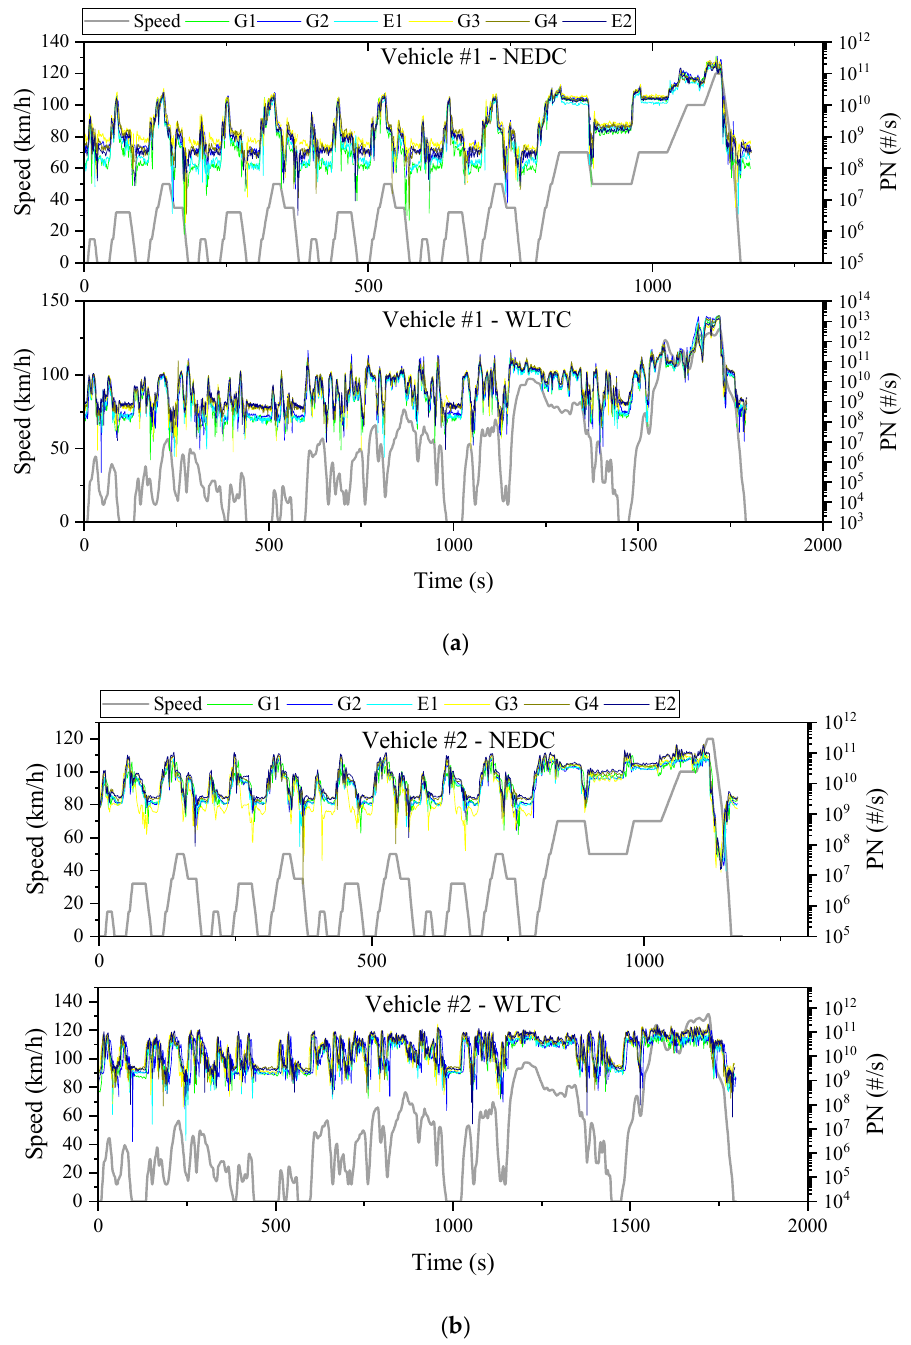
Figure 6. Instantaneous particle number emissions from the two vehicles during the NEDC and WLTC tests with different fuels: ( a ) Vehicle #1; ( b ) Vehicle #2. When the vehicle is at a high speed (EUDC phase in the NEDC and extra-high-speed phase in the WLTC) the engine speed and load are at a higher level, and the combustion time of fuel becomes shorter. The particle number increases sharply with incomplete com- bustion. When the vehicle accelerates, the inlet pipe pressure rises and more gasoline is needed to achieve better power, which leads to an increase in fuel consumption. Hence, the engine generates more particulate matter.